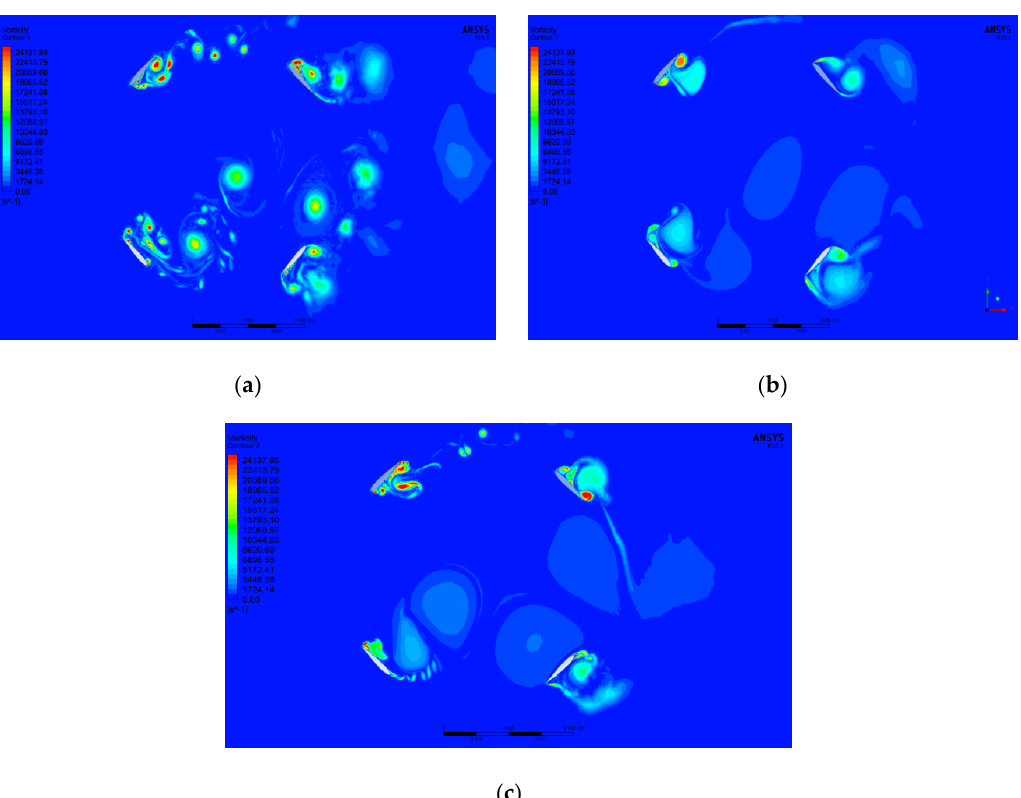
Figure 13. Contours of vorticity for DDES ( a ), RANS Transition ( b ) and RANS SST k-ω ( c ) at 45° azimuthal position at λ max = 0.29.